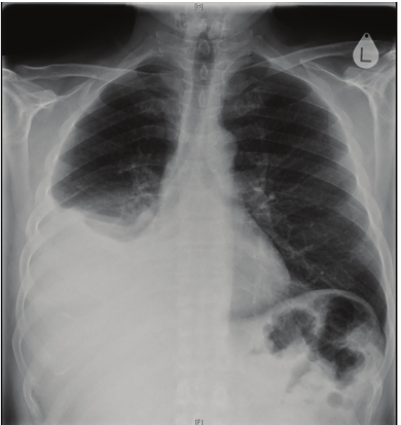
Figure 3: Chest radiography 6 months after diagnosis showing drastic improvement. The lungs were clear except for a small persistent right-sided pleural effusion. The cardiothoracic ratio and the mediastinal contours were